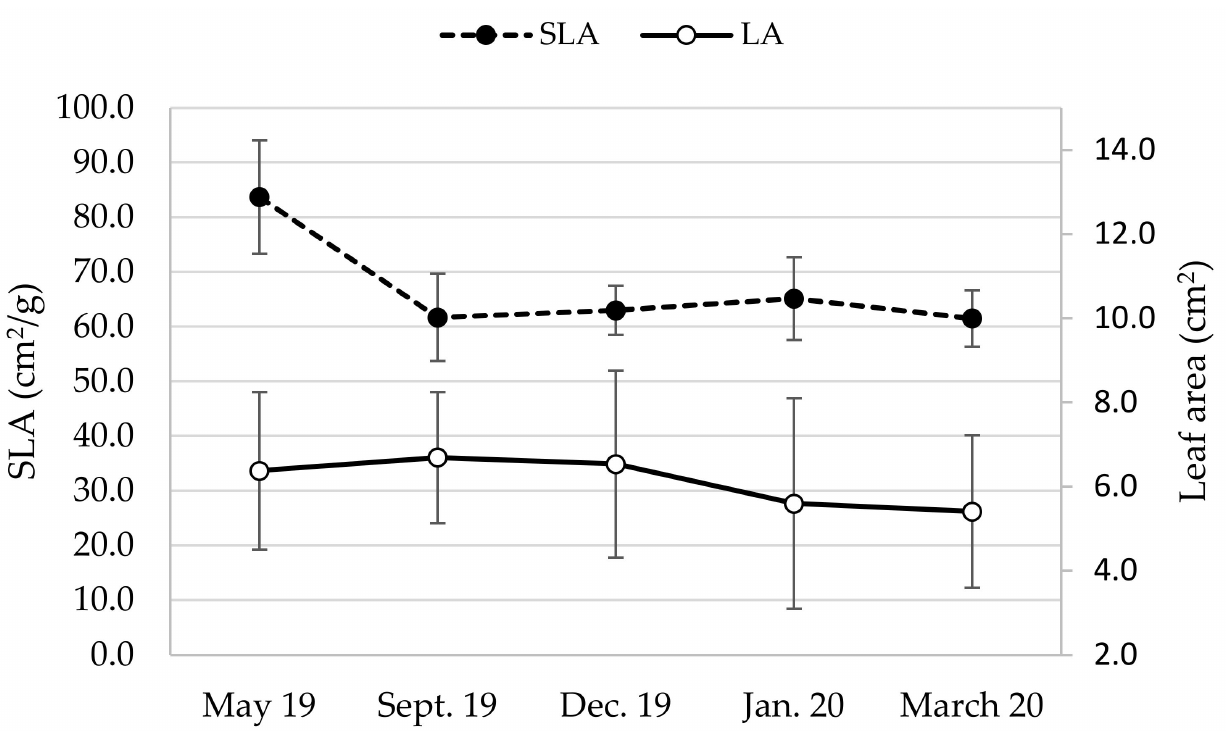
Figure 1. Variation in leaf area (LA, empty circles) and specific leaf area (SLA, filled circles) in Quercus suber along one year (mean of six provenances with two trees per provenance and standard, deviation as bars).